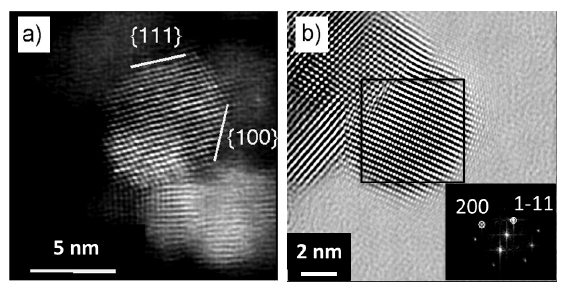
Figure 3: STEM (a) and HRTEM (b) images of ceria NPs corres- ponding to the sample with average diameter of 9 nm, the inset in (b) shows the FFT of the selected area with indicated the corresponding